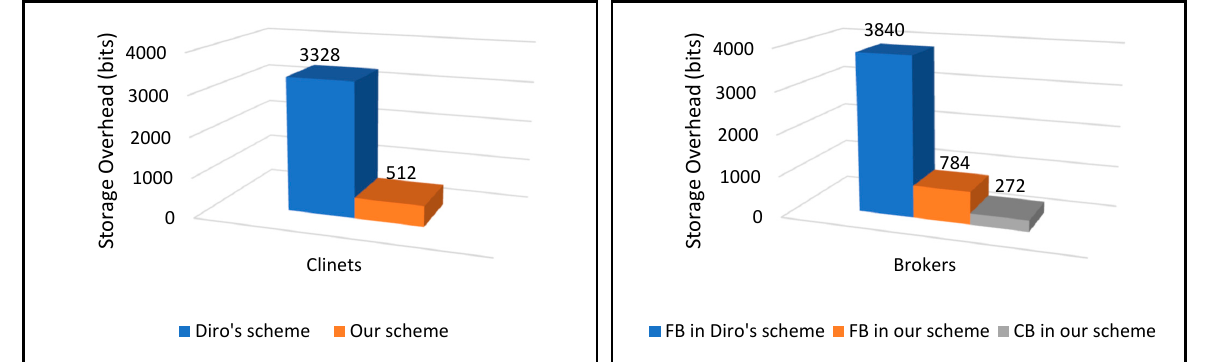
Figure 12. Storage overhead for clients and brokers in Diro’s scheme and our scheme.